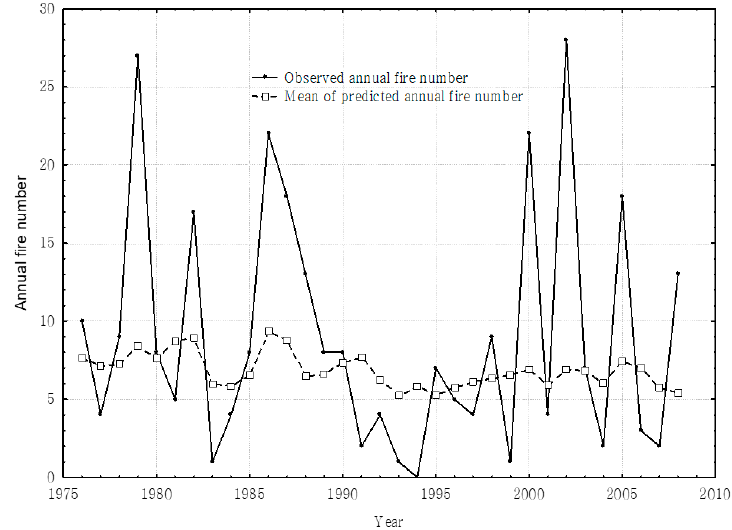
Figure 6. Comparison of observed and predicted annual fire number for the northern part of the Daxinganling Region from 1976 to 2008.